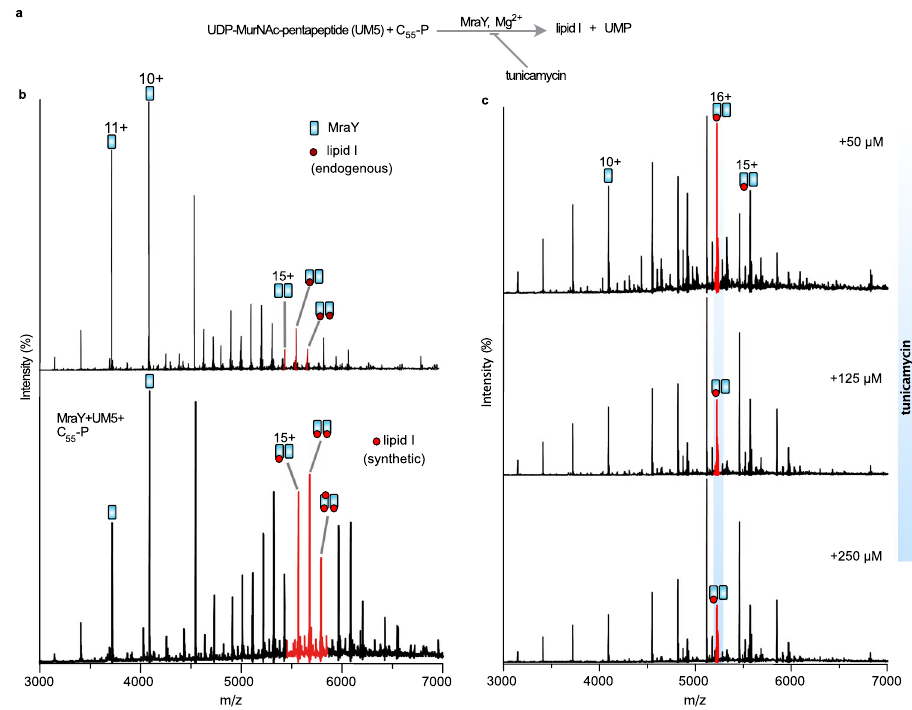
Fig. 3 Monitoring enzymatic activity and inhibition of MraY. a A reaction scheme illustrating MraY-mediated synthesis of lipid I and inhibition by tunicamycin. UMP uridine monophosphate. b Native mass spectrum of MraY bound to endogenous lipid I (top panel) and incubated with a tenfold molar excess of C 55 -P and UM5 for 16 h (lower panel) in buffer containing 0.02% DDM, 20 mM Tris (pH 8.0), 200 mM NaCl, of 2 mM Mg 2 + and 10% glycerol. Spectra were acquired after incubation and buffer exchange into 0.5% C8E4, 200 mM ammonium acetate, pH 8.0. Uridine monophosphate (UMP) is released as a by-product (not observed). Although MraY catalysis does not occur at the dimer interface, molecules of lipid I, synthesised in situ, were captured as adducts to the dimer (mass 1674 Da). In the presence of synthetic lipid I, the total intensity of peaks assigned to dimeric MraY is higher than for the protein control without substrates added (cf. Fig. 1b). For clarity, the dimer (15 + ) and lipid-bound charge states are highlighted (red). c The same lipid I synthesis reaction as above but performed in the presence of an increasing concentration of tunicamycin. The number and intensity of synthetic lipid I adducts decrease with increasing tunicamycin concentration. Excess substrate and inhibitor molecules were removed via buffer exchange prior to consistently higher af fi nity for C 55 -P than the Q260A/R340A mutant (Supplementary Fig. 6c). Overall, these data con fi rm